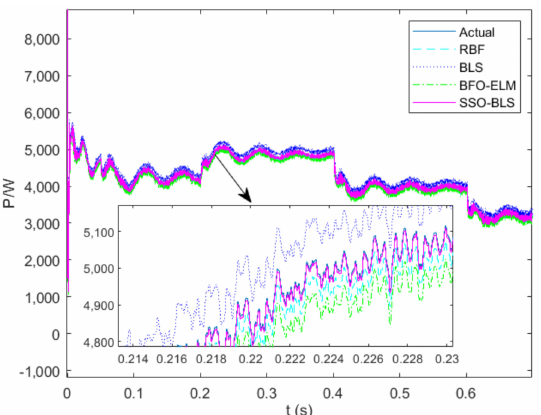
Figure 10. Power comparison of different equivalent models when the power of photovoltaic distributed power plants